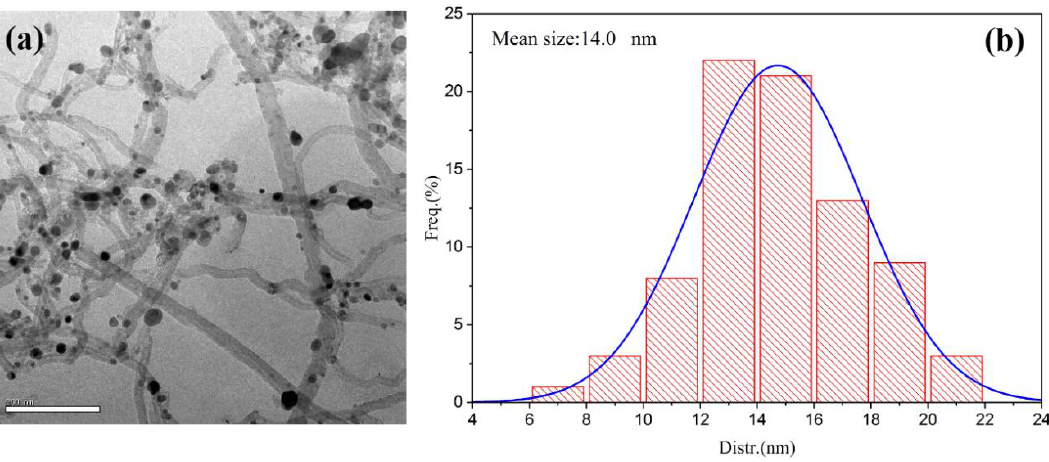
Figure 3. Characterization of the 20% Ni/CNT catalyst. ( a ) TEM image of 20% Ni/CNT, ( b ) Distribution of Ni particles.